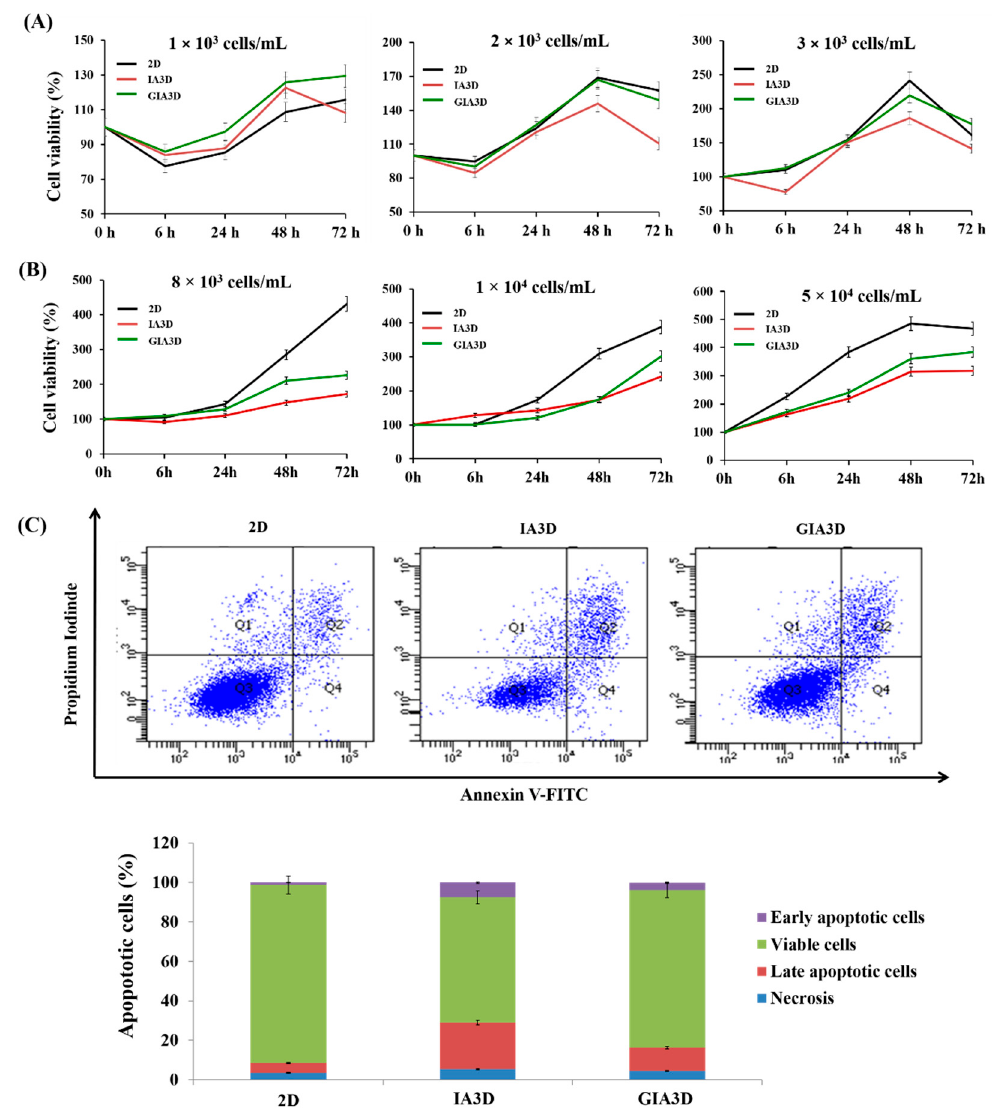
Figure 8. Evaluation of HepG2 and HaCaT cells viabilities. ( A , B ) Viabilities of HepG2 cells, HaCaT cells in two-dimensional culture, industrial acrylonitrile butadiene styrene (IA3D), and gold nanoparticle-coated ABS sca ff old (GIA3D). Cells were seeded at a density ranging from 1 × 10 3 –3 × 10 3 cell / mL for HepG2 cells to 8 × 10 3 –5 × 10 4 cell / mL. Viabilities were measured at 0 h, 6 h, 24 h, 48 h, and 72 h of culture. The percentage (%) of viable cells was calculated and plotted. Results are expressed as mean ± SD, n = 3. ( C ) Determination of the apoptotic HaCaT cell populations by Annexin V-FITC / propidium iodide staining in 2D culture, IA3D, and GIA3D. Cells were cultured at a density of 5 × 10 4 cells / mL for 3 days. The experiments were performed in triplicate. After 3 days of culture, IA3D induced cell apoptosis (31.2%), which was lower in the GIA3D sca ff old (15.3%) and minimal in 2D culture